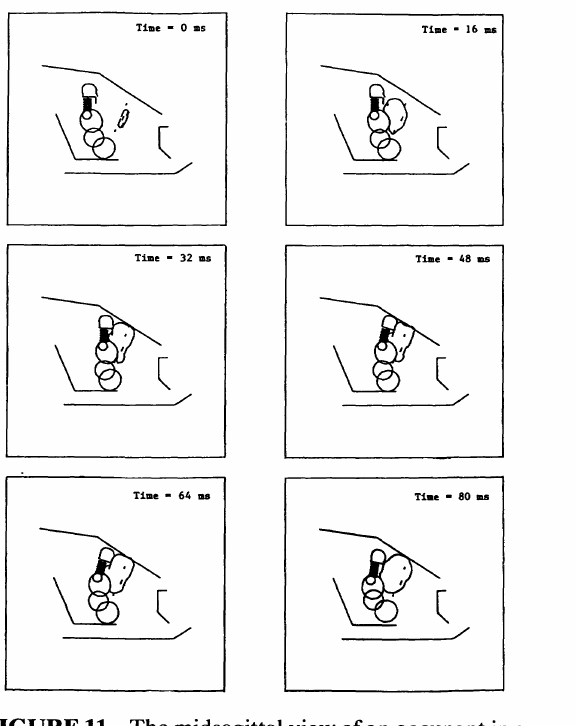
FIGURE 11 The midsagittal view of an occupant in a car with a pleated accordion fold airbag at 30° (case